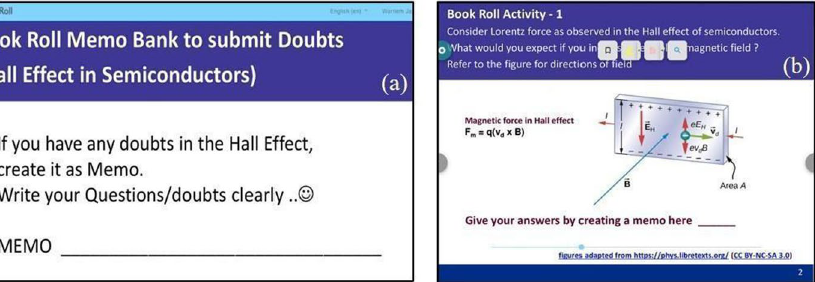
Fig. 3 Examples of a clarification spot and b reflection spot activity created in BookRoll